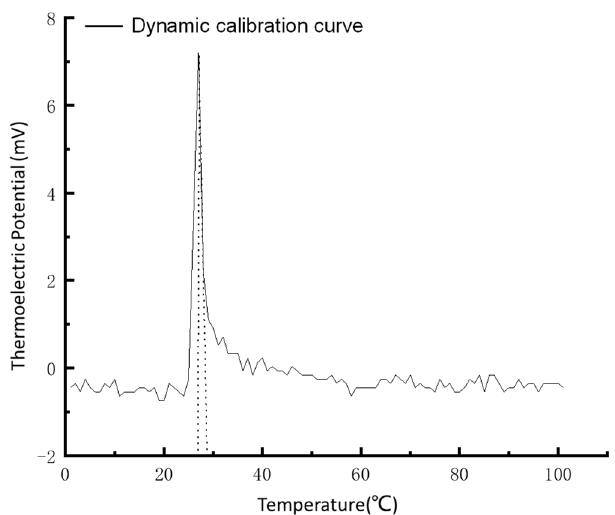
Figure 14. Dynamic calibration curve of a thin-film thermocouple temperature sensor. According to the curve calculation, the response time of the thin-film thermocouple temperature sensor is 1.42 μ s, and the response time is a microsecond. Therefore, the sen- sor can meet the requirements (1.6 ms) of temperature measurement of the bearing’s roll- ing elements during train operation.